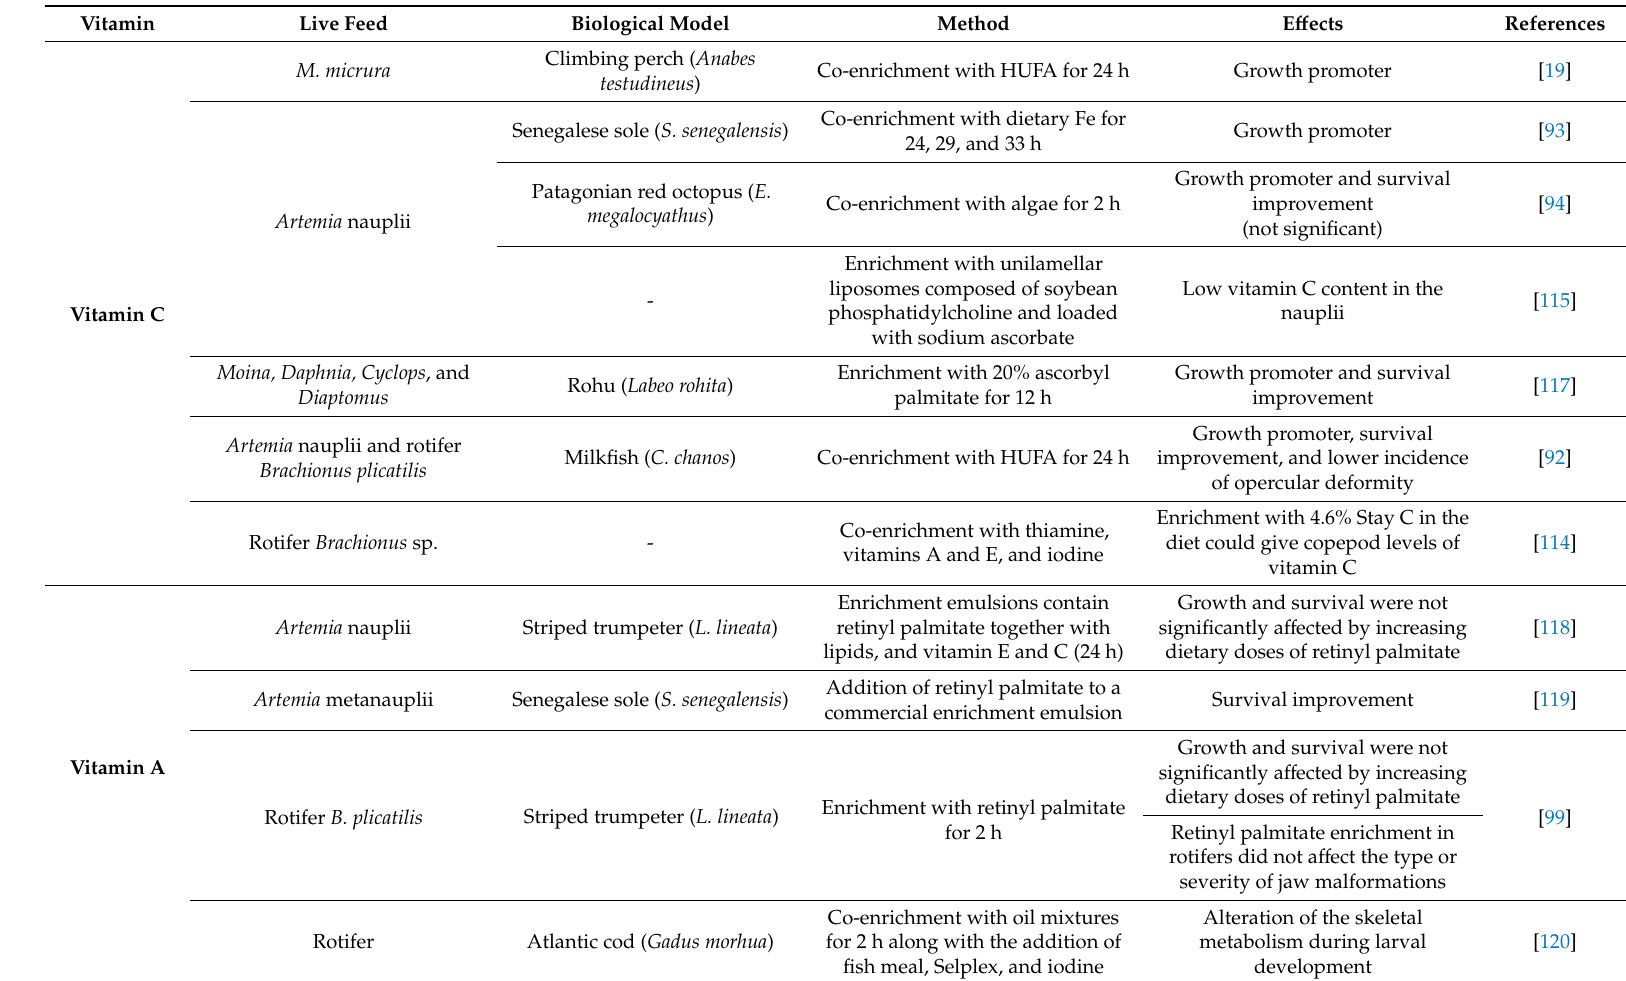
Table 1. Enrichment of live food with